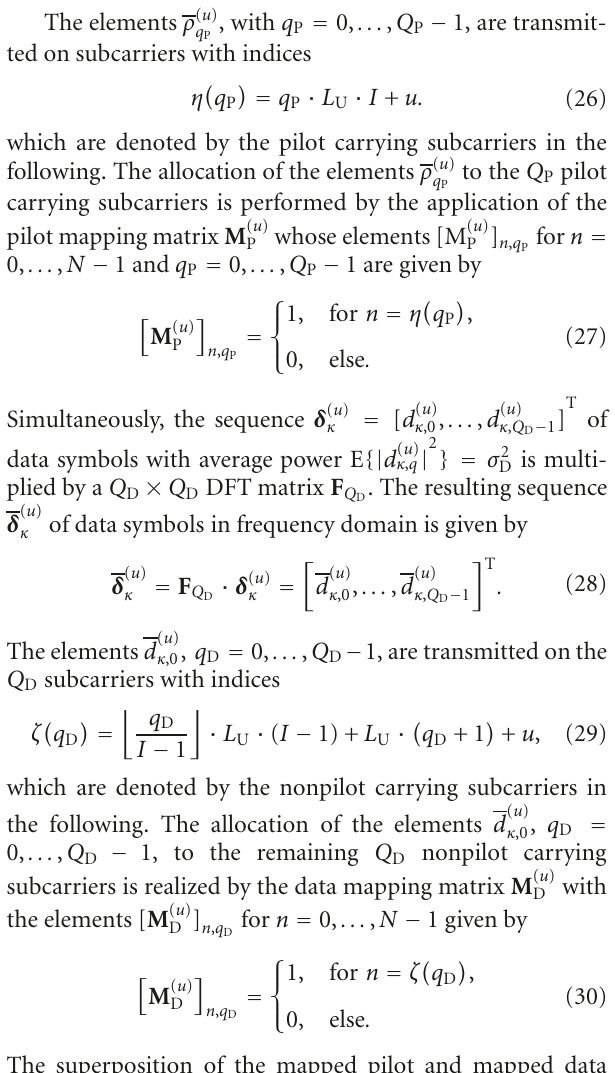
Figure 3: Discrete-time transmission chain.